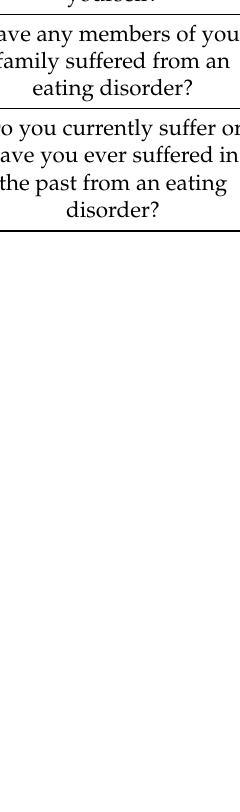
Table 5. Answers to questions on habitual overeating in males and